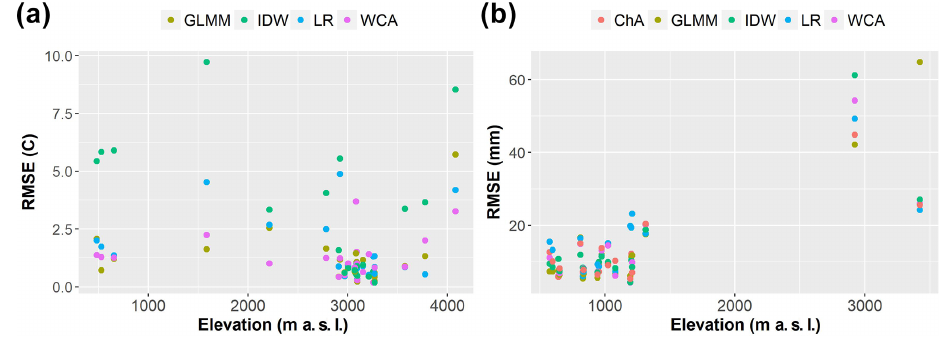
Figure 7. (a) Elevation of gauges vs. average temperature RMSE in the LOOCV. (b) Elevation of gauges vs. average precipitation RMSE in the LOOCV.